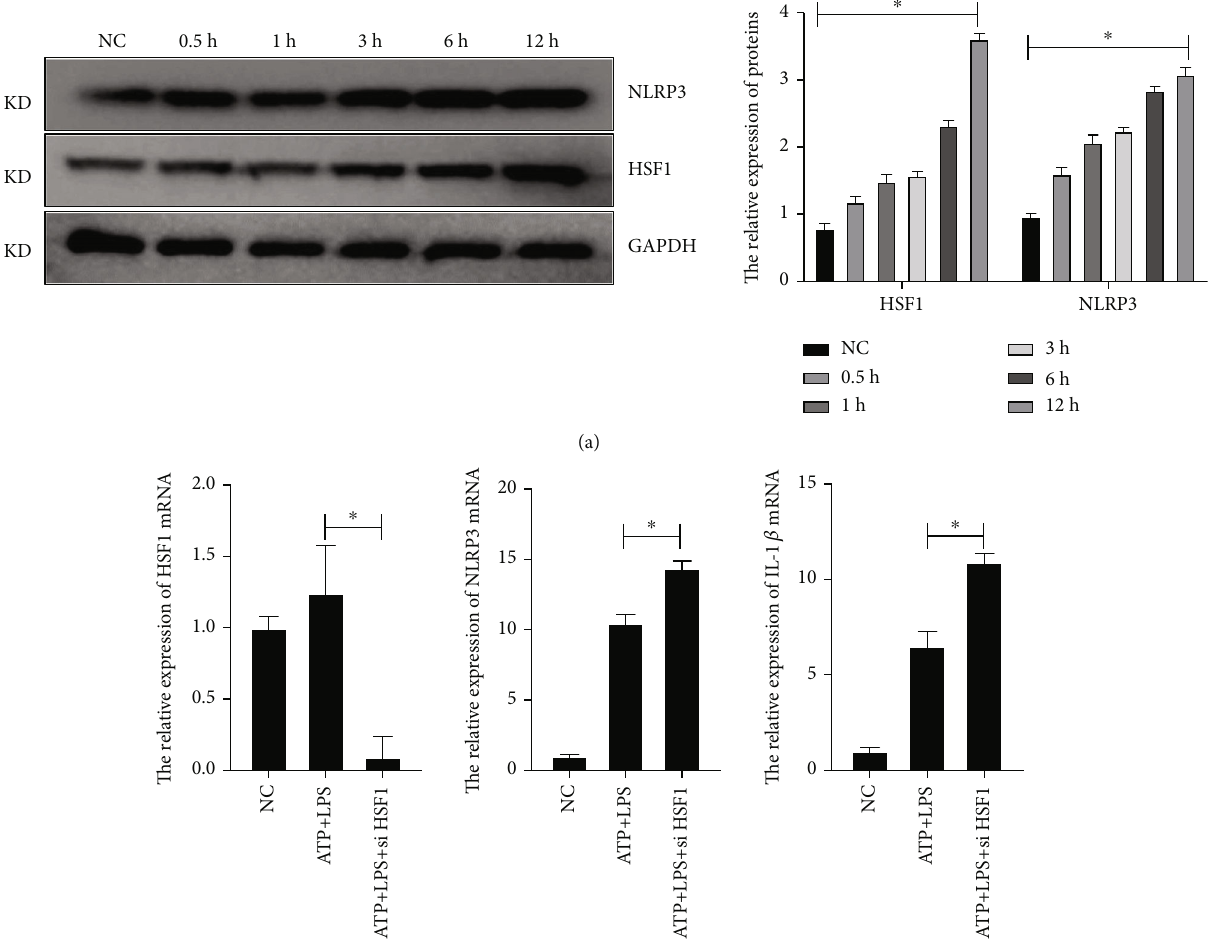
Figure 5: HSF1 and NLRP3 expression in LPS+ATP-treated PC12 cells. (a) Western blot was used to detect the expression of the NLRP3 and HSF1 in PC12 cells at di ff erent times treated by LPS+ATP. The statistical analysis of WB is shown in the graph. Experiments were repeated independently, ∗ p < 0 : 05 vs. negative control. (b) qPCR detected the expression of HSF1, NLRP3, and IL-1 β in PC12 cells treated with LPS+ATP. Experiments were repeated independently, ∗ p < 0 : 05 vs. negative